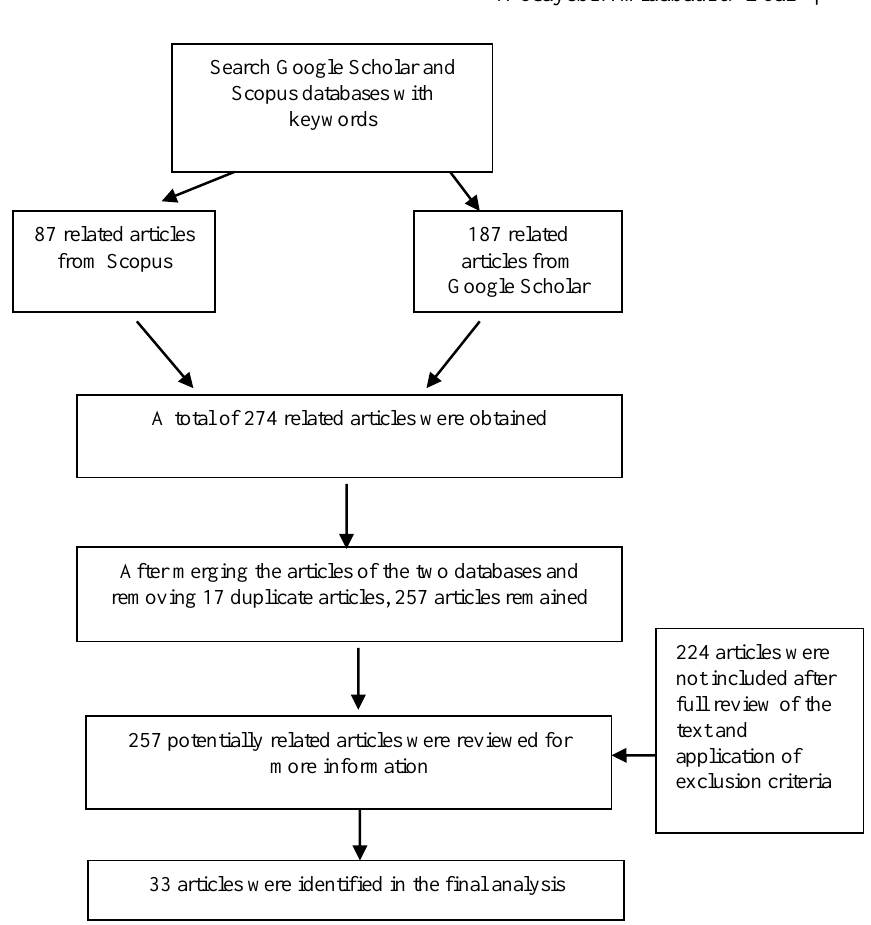
Figure 3 - Identification and selection of related research in the field